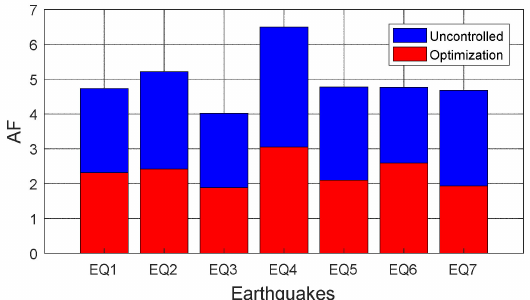
Figure 28. Amplification factor (AF) due to seismic loads of the electrical cabinet with and without a TMD.